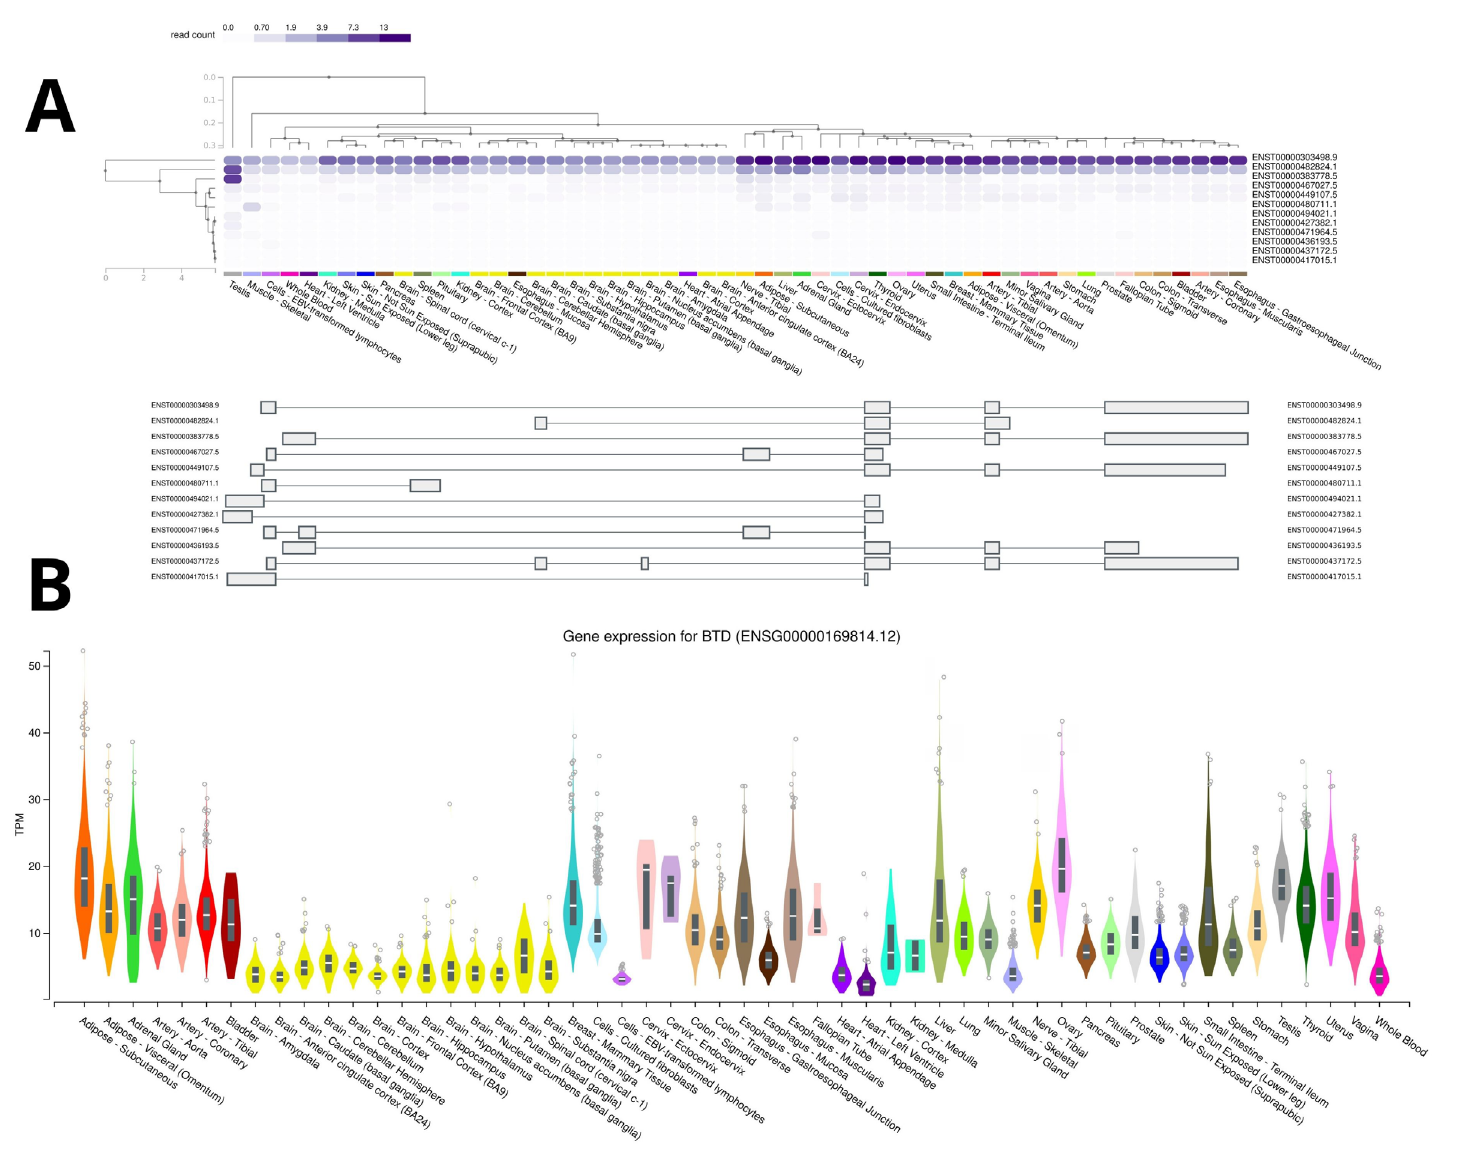
Figure 1 – BTD gene expression. A: Isoforms in human tissues. B: Expression pattern in several tissues and organs. Adapted from GTEx